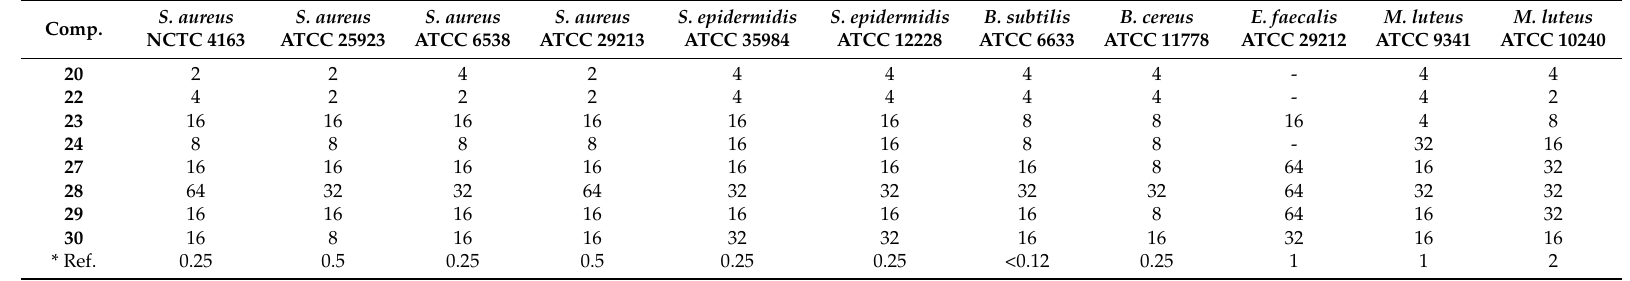
Table 2. Activity of compounds against standard bacterial strains, expressed as minimal inhibitory concentrations (MIC, µ g/mL). Comp.